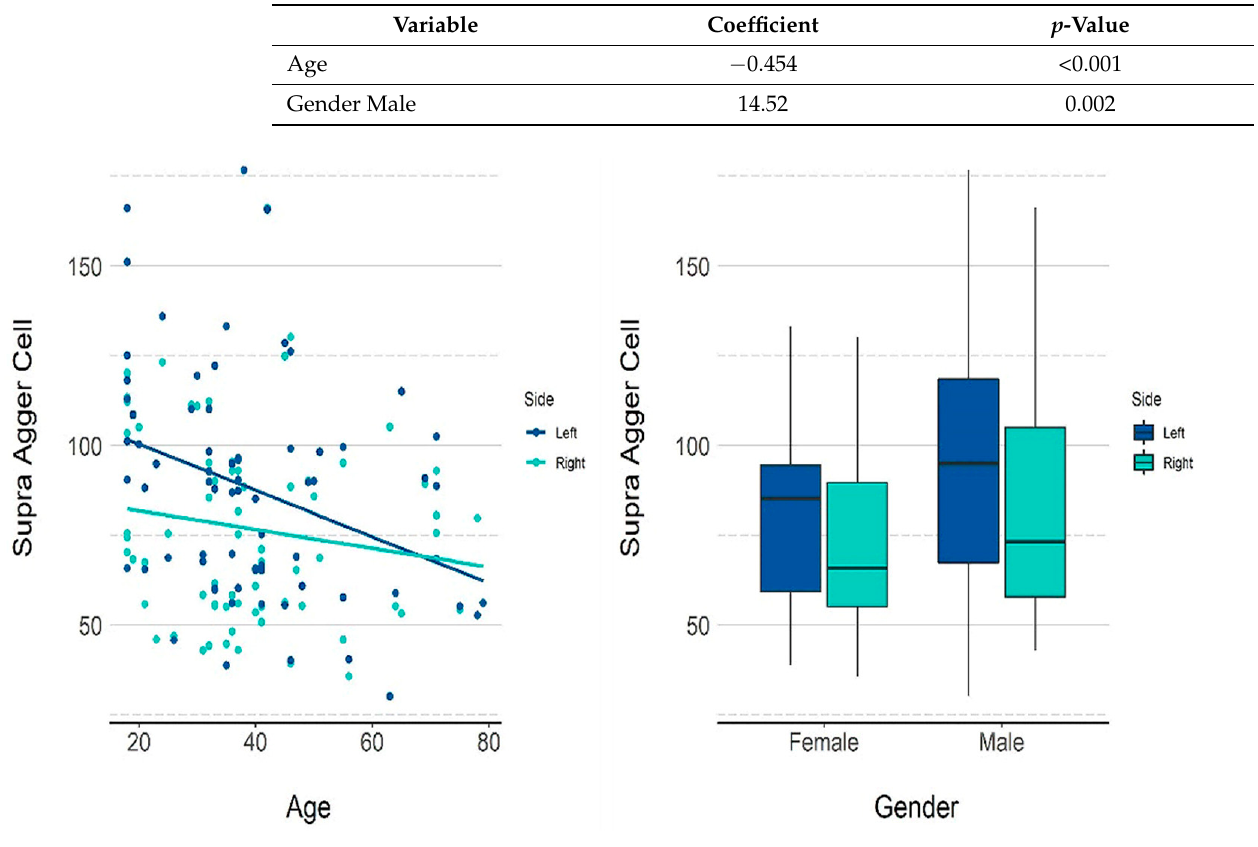
Figure 4. GEE model and scatter plots showing the influence of age and gender on the volume of the